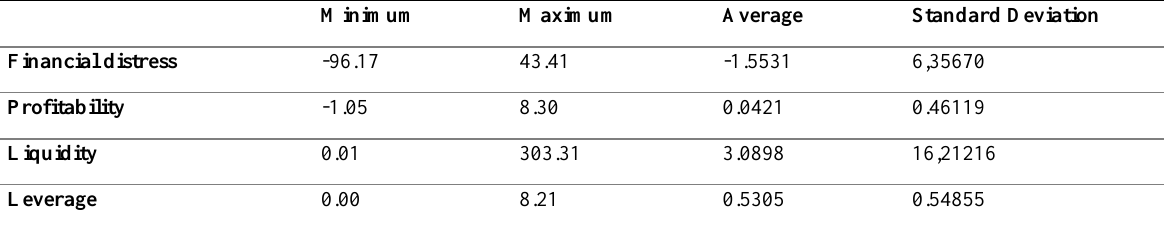
Table 2 : Descriptive Statistics of Financial distress During Covid-19